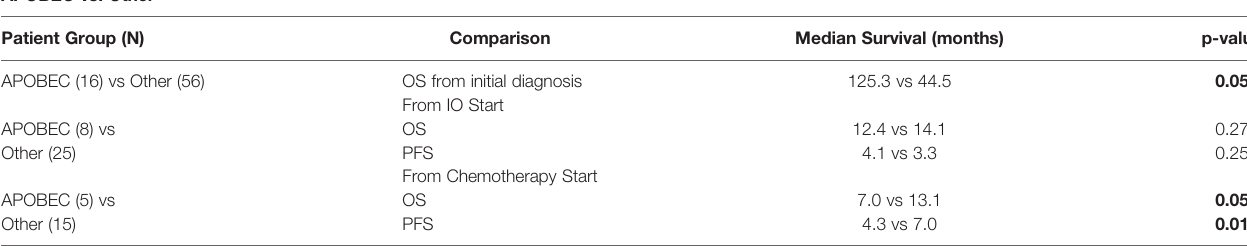
TABLE 4 | Comparison of outcomes in APOBEC vs Other patients. APOBEC vs.